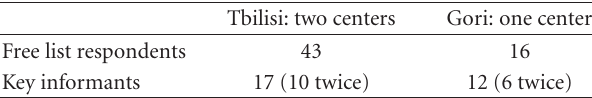
Table 1: Numbers of study 1 respondents, across sites. Table 2: Study 1 free list responses, causes of children going to the street, Tbilisi and Gori combined, ( N = 59).